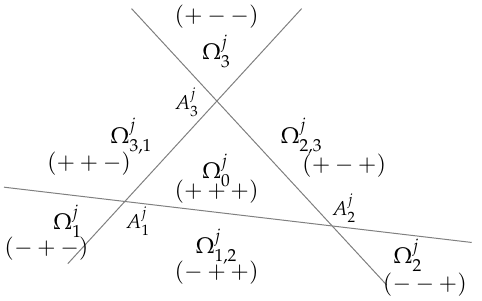
Figure 8. The seven regions determined by the triangle T j , with associated